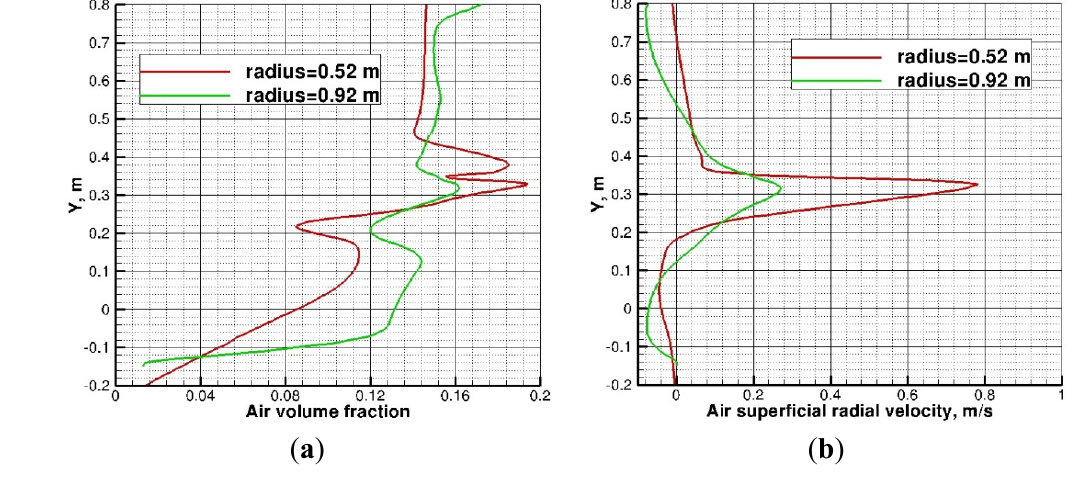
= 0.92 m/s) showing jets w